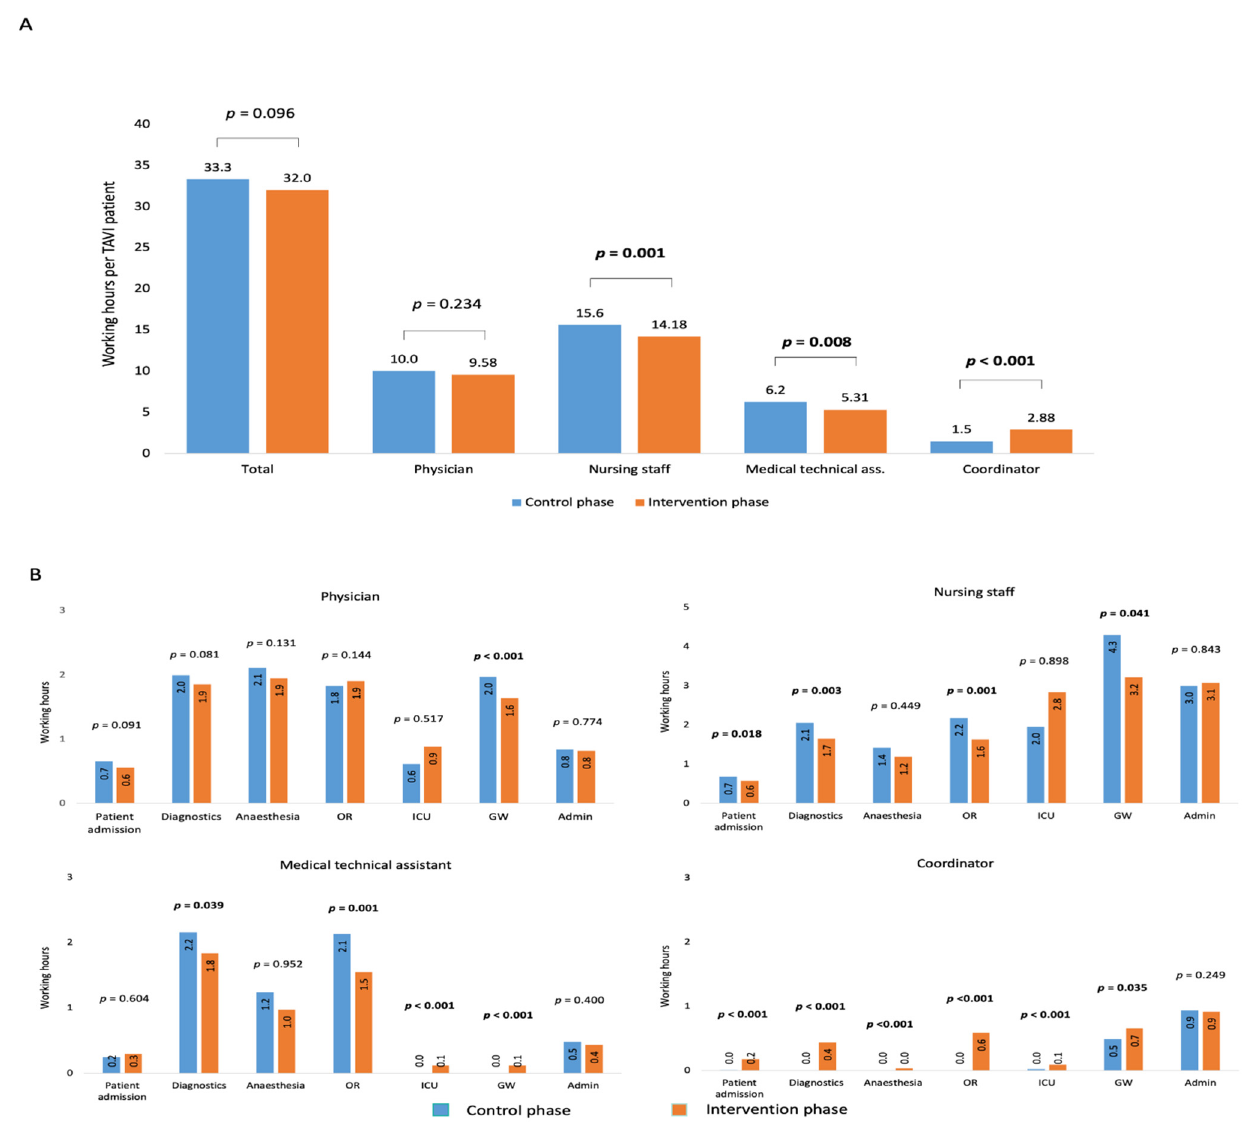
Figure 4. Working hours for physicians, nursing staff, medical technical assistants, and coordinators ( A ) overall and ( B ) differentiated into subcategories for control vs. intervention phases. GW, general ward; ICU, intensive care unit; OR, operating room.